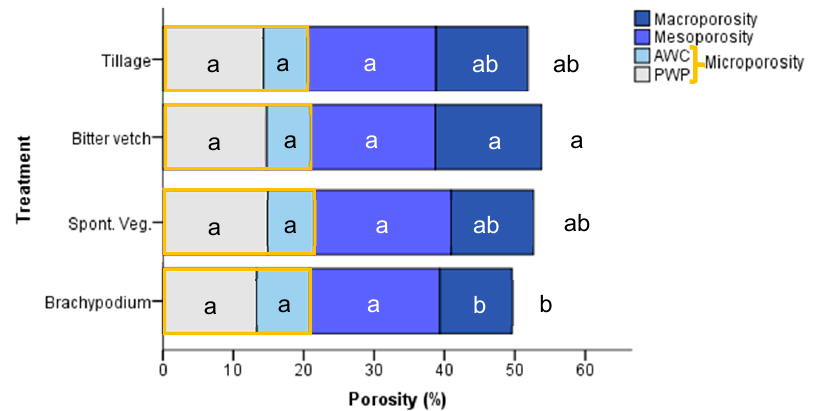
Figure 6. Porosity fractions in the different treatments. Different letters mean significant differences between treatments at p < 0.05 according to Tukey test (N = 12) in the different porosity fractions. DOY: Day of the year.